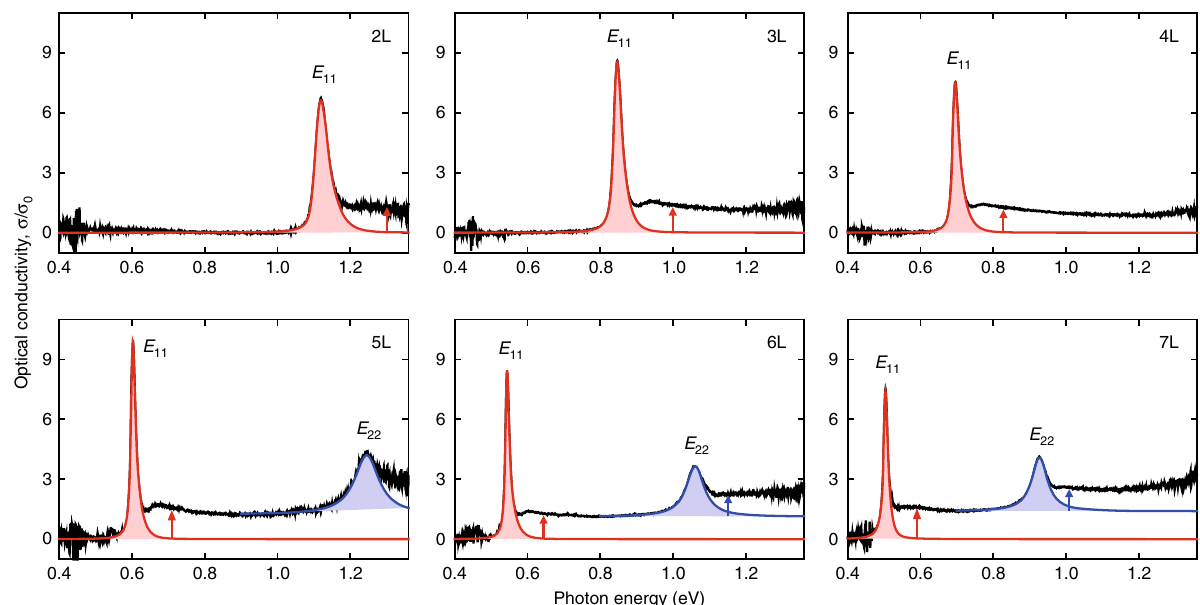
Fig. 2 Room-temperature IR measurements. Optical conductivity σ ( ħ ω ) spectra of few-layer BP with layer number N = 2 – 7, with incident light polarized along the AC direction, in the unit of σ 0 = e 2 /4 ħ . E 11 ( E 22 ) denotes the 1 s excitonic transition associated with the fi rst (second) pair of subbands, as illustrated in Fig. 1b. The slightly asymmetric E 11 peaks are fi tted using Eq. (3) in Methods (red curves), while E 22 peaks are fi tted to symmetric Lorentzian lineshapes (blue curves). The exciton absorption (or conductivity σ I ) is proportional to the integrated areas of the exciton peaks, as indicated by the shaded areas. The vertical arrows indicate the height of the continuum absorption for each subband